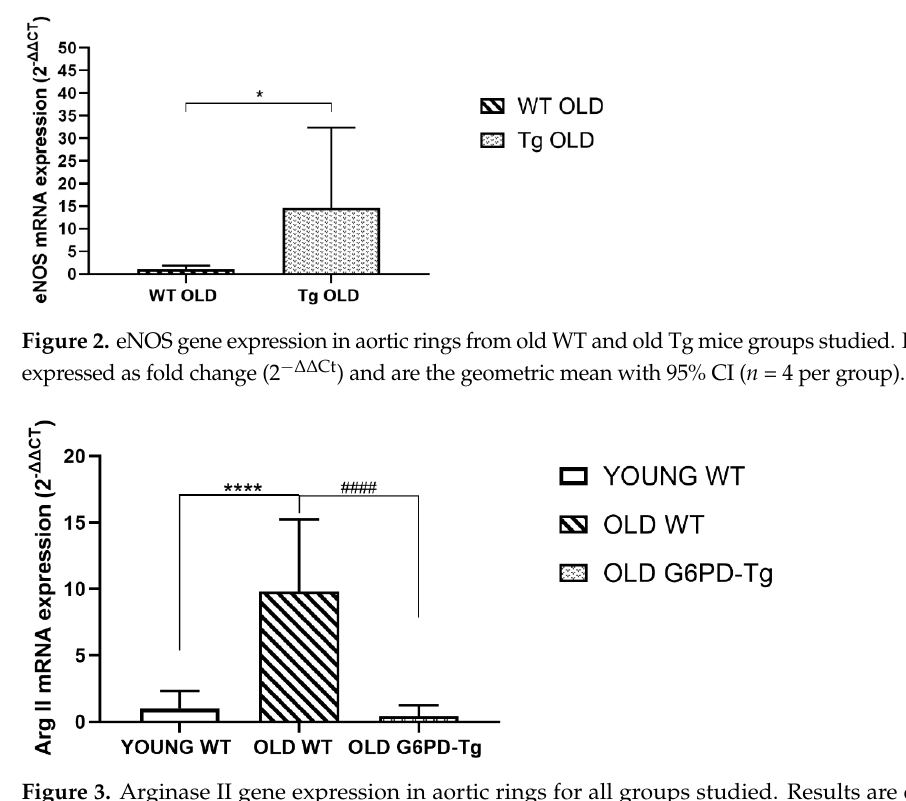
Figure 3. Arginase II gene expression in aortic rings for all groups studied. Results are expressed as fold change (2 −ΔΔ Ct ) and are the geometric mean with 95% CI ( n = 4 per group). **** p < 0.0001 between WT groups. #### p < 0.0001 between old